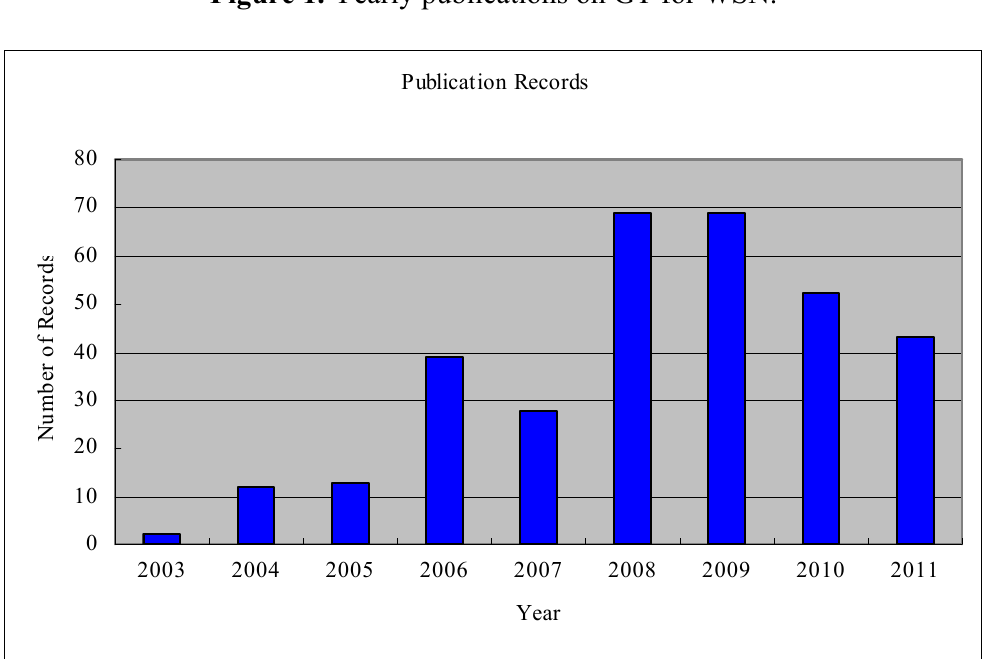
Figure 1. Yearly publications on GT for